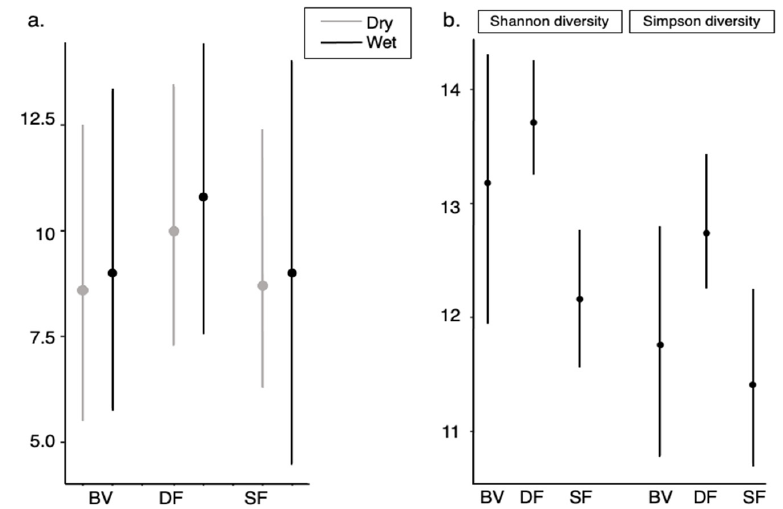
Figure 3. Richness estimates: ( a ) Camera-level and ( b ) Sampling-area estimates using two estimators Shannon and Simpson indexes in the Bahia forest of southwestern Ecuador.